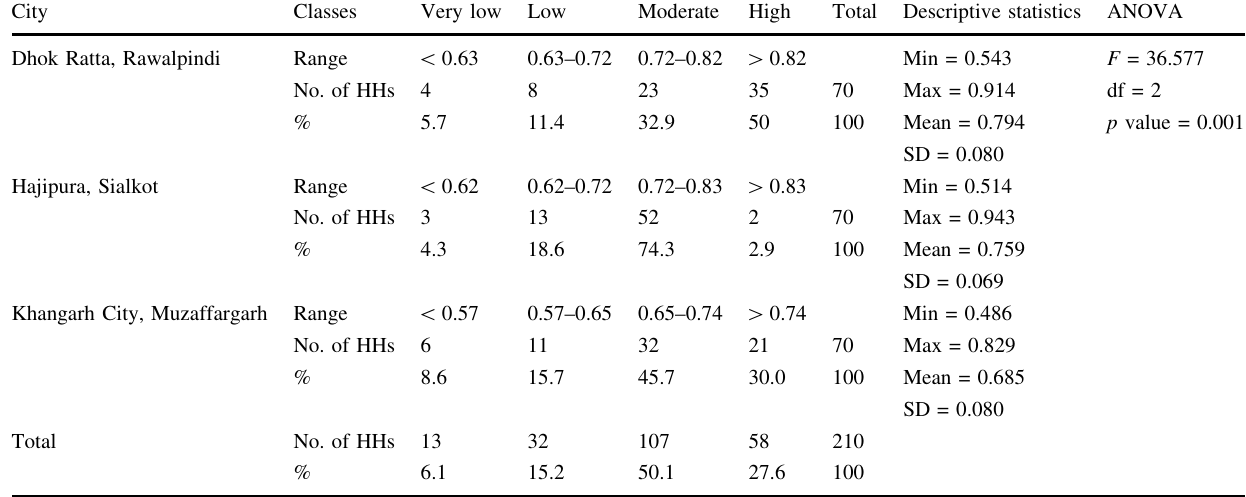
Table 6 Attitudinal vulnerability to urban flooding in Dhok Ratta, Hajipura, and Khangarh City, Punjab Province, Pakistan (HHs = Households; n = 210)